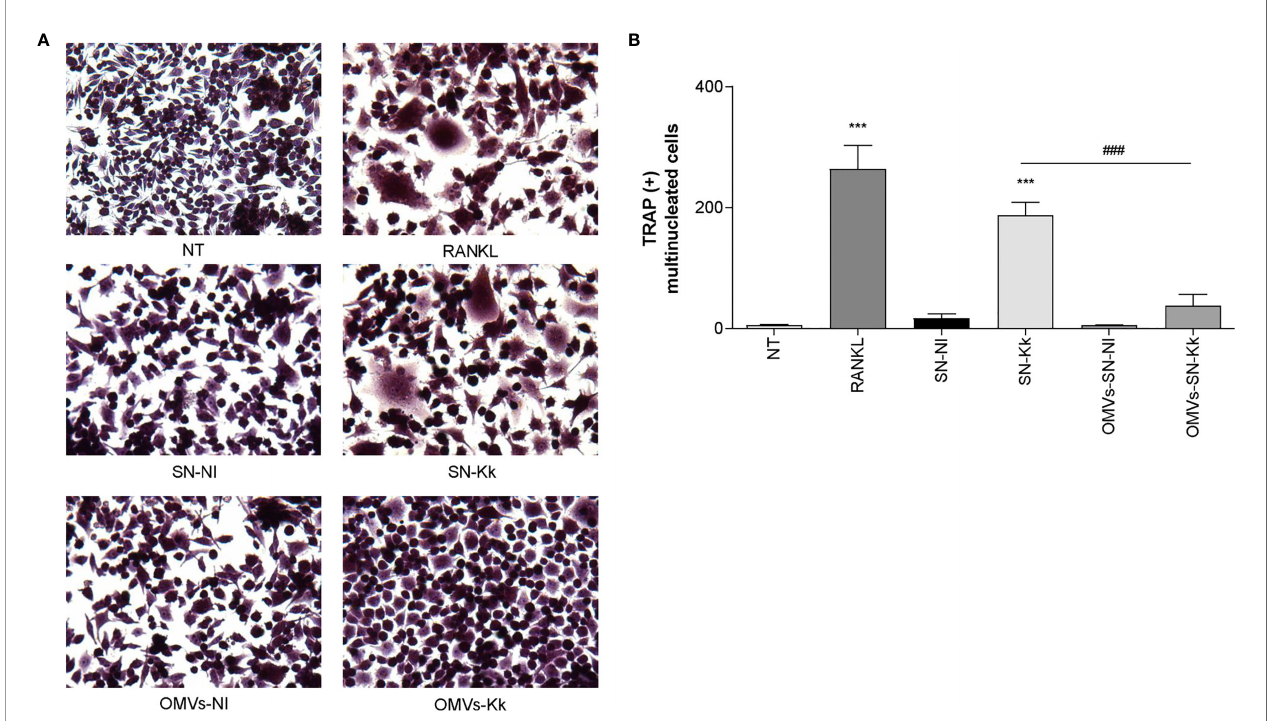
FIGURE 6 | Pretreatment with outer membrane vesicles (OMV) decreases the osteoclastogenesis induced by supernatants from monocytes infected with Kingella kingae . RAW 264.7 cells were stimulated with culture supernatants from K. kingae -infected THP-1 monocytes (multiplicity of infection = 1) pretreated with OMV (10 µg/ml; OMV-SN-Kk) or with culture supernatants from non-infected THP-1 monocytes pretreated with OMV (OMV-SN-NI) or with supernatants non-pretreated with OMV (SN-Kk and SN-NI, respectively) added at a 1:2 proportion in conjunction with macrophage colony-stimulating factor. After 7 days, osteoclastogenesis was determined by the generation of TRAP-positive multinucleated cells (more than three nuclei). Representative digital images were taken by light microscopy (A) , and TRAP-positive multinucleated cells were identi fi ed and counted (B) . RANKL was used as a positive control. NT, non-treated. The graphics are showing values obtained from three independent experiments. Data are given as mean ± SD. *** P < 0.001 versus cells treated with SN-NI or NT. ### P <